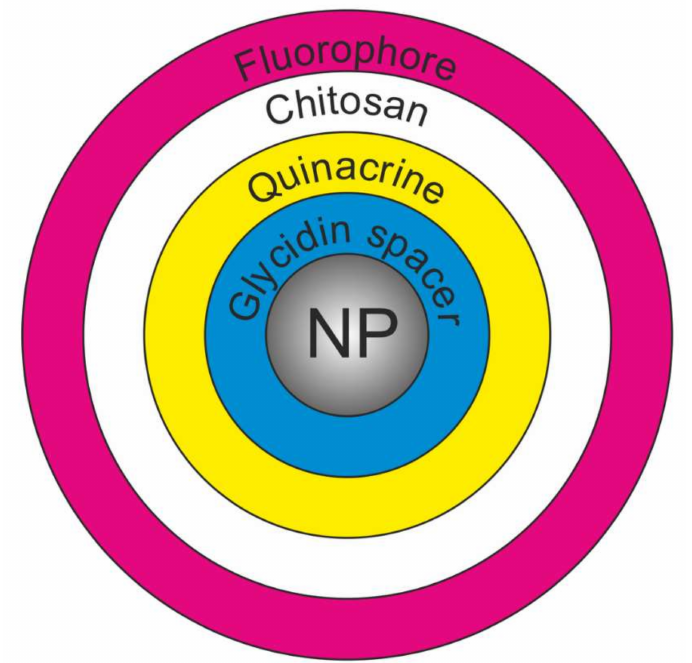
Figure 1. Schematic diagram of a core–shell nanostructure, SNP(MNP)-GPMS-quinacrine-chitosan-